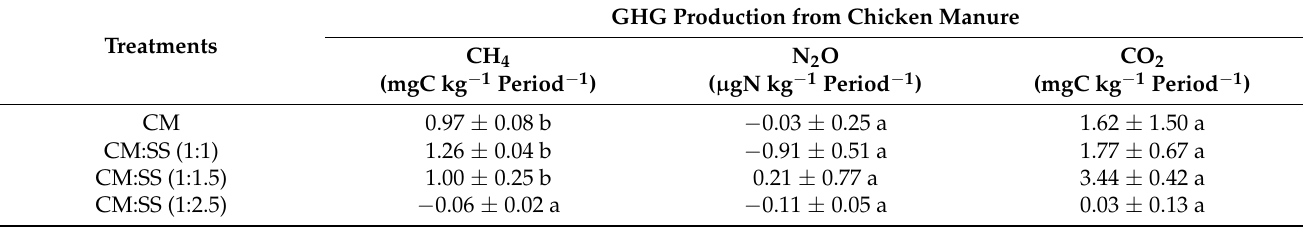
Table 2. GHG production from chicken manure in each treatment during the incubation experiment (Mean ± Standard Error). GHG Production from Chicken Manure Treatments